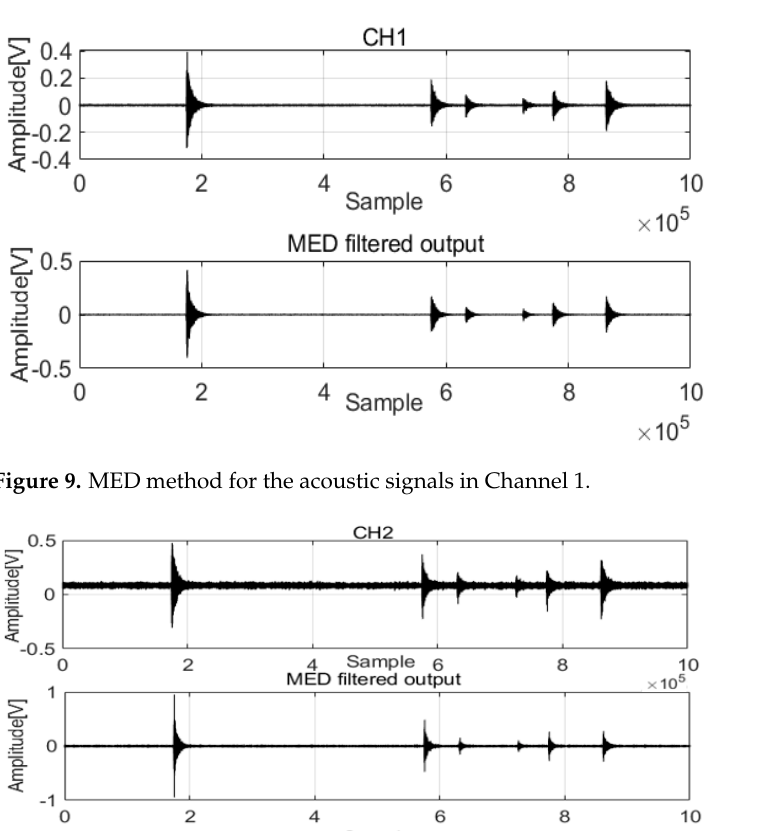
Figure 8. Acoustic waves of two channels.